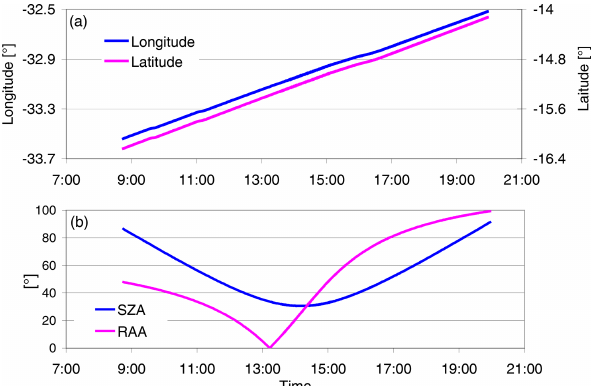
Figure A6. (a) Variation of the latitude and longitude of the ship position during 2 May 2019. (b) Corresponding variation of the SZA and relative azimuth angle (RAA).